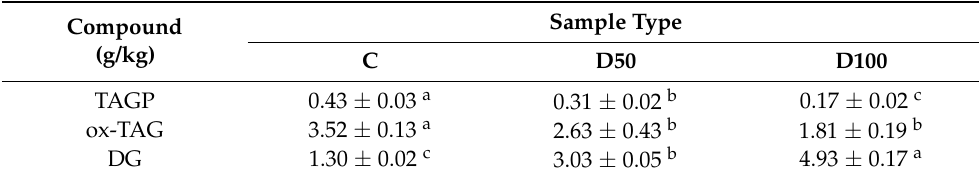
Table 5. Polar compounds of the lipid fraction of the experimental biscuits. C = Biscuits prepared with 100% sunflower oil; D50 = biscuits prepared with sunflower oil (50%) and durum wheat oil (50%); D100 = biscuits prepared with 100% durum wheat